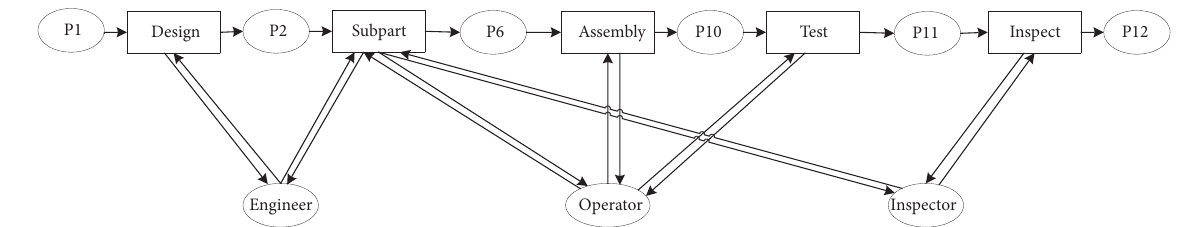
Figure 9: CPN model for the whole process.